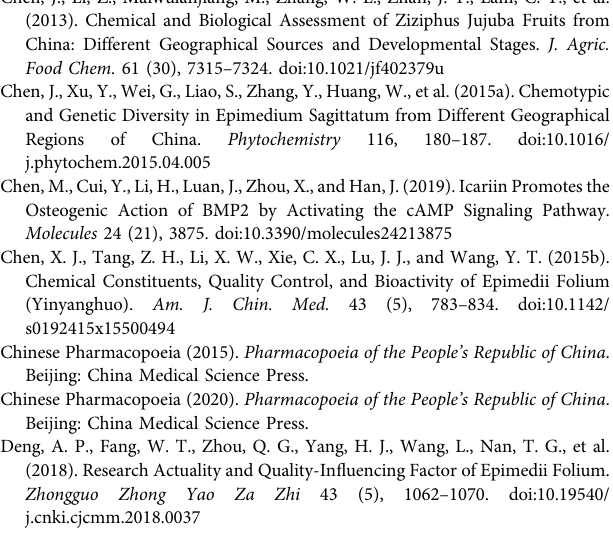
Frontiers in Pharmacology |